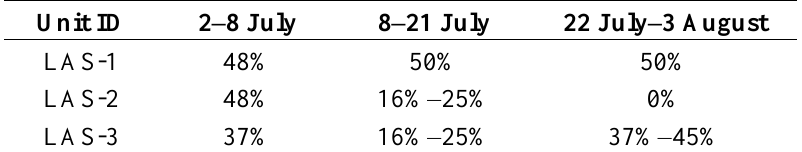
Table 1. Demodulated signal strength given in analog (0%–100%) format for the three LAS units during the inter-comparison study. 8 July and 21 July divide the study period due to the changes in alignment for one or more of the LAS units observed on those